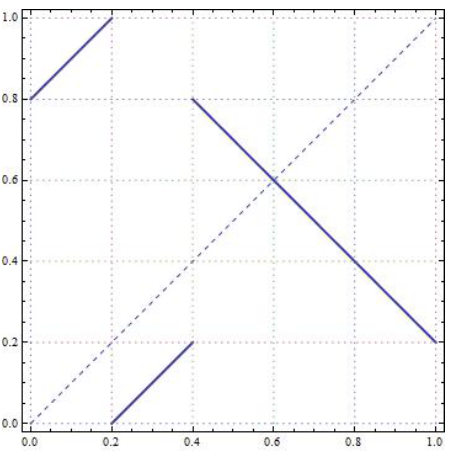
(cid:17) (cid:16) 1 , 1 , 3 . Note the intervals ( j /5, ( j + 1 ) /5 ) for 5 5 5